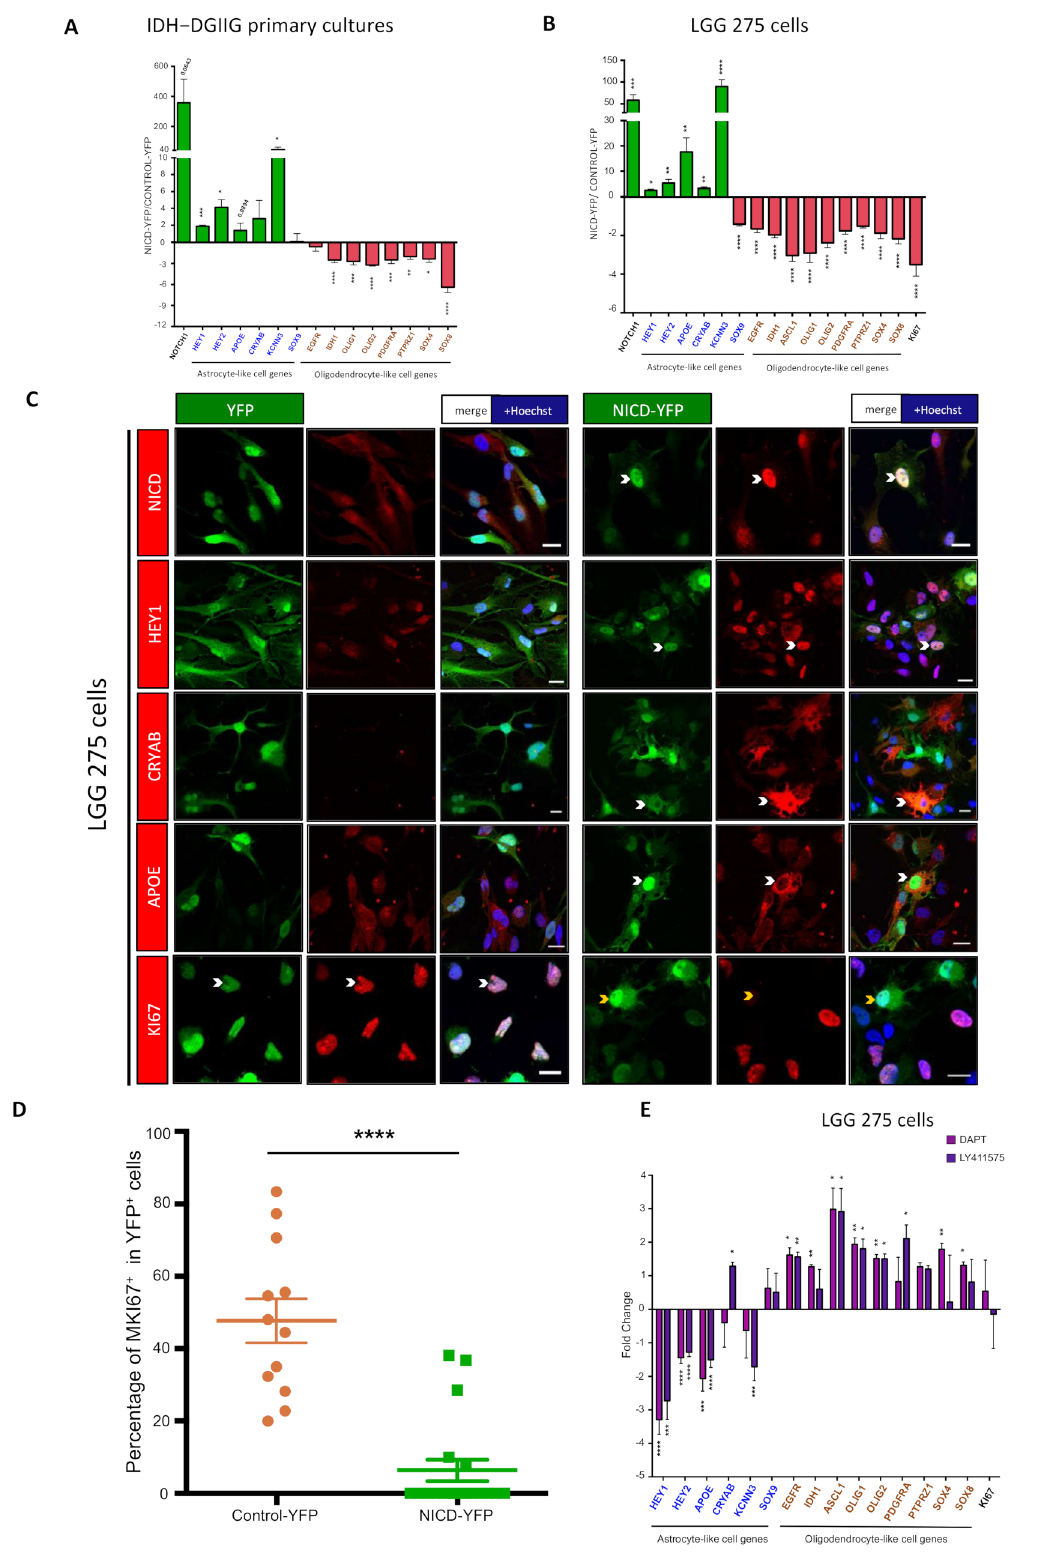
Figure 5. NOTCH1 activation modifies IDH-DGIIG cell phenotype and reduces proliferation. ( A , B ) QPCR analysis for indicated genes in O4-purified primary cultures containing a high % of tumoral cells (>70%; n = 4 cases, astrocytomas) ( A ) and in LGG275 cells ( n = 5 independent experiments) ( B ). Values represent the mean ± SEM of gene expression fold change observed in cells transduced with NICD-YFP vs. YFP lentiviruses. Genes in blue and brown are markers found preferentially associated with SOX9 + and OLIG1 + cells, respectively, on IDH-DGIIG sections. Tests =